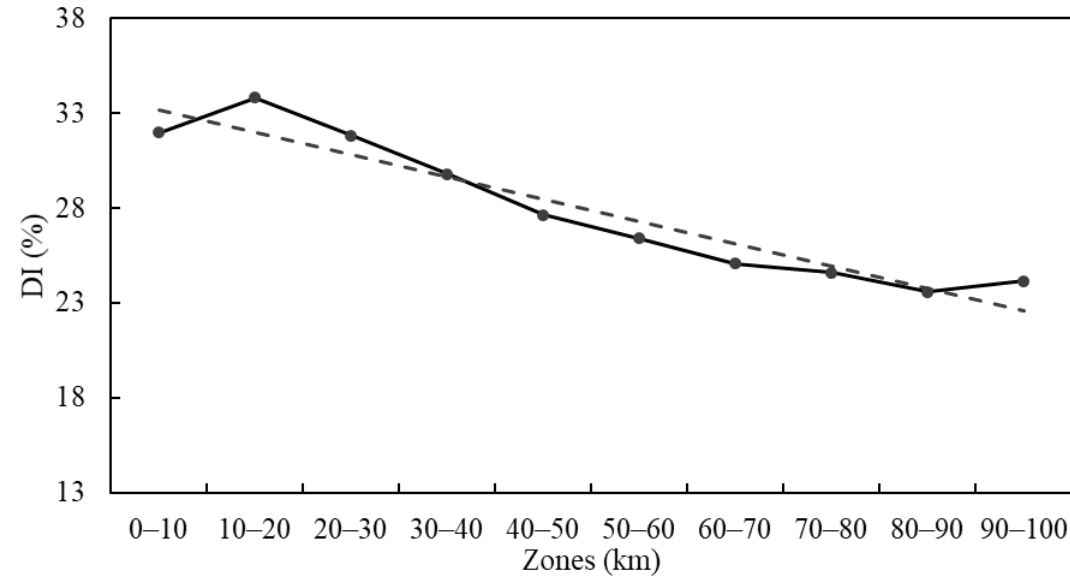
Figure 14. The difference index (DI) describing the change of NDVI–climate response in different Figure 14. The di ff erence index (DI) describing the change of NDVI–climate response in di ff erent zones.